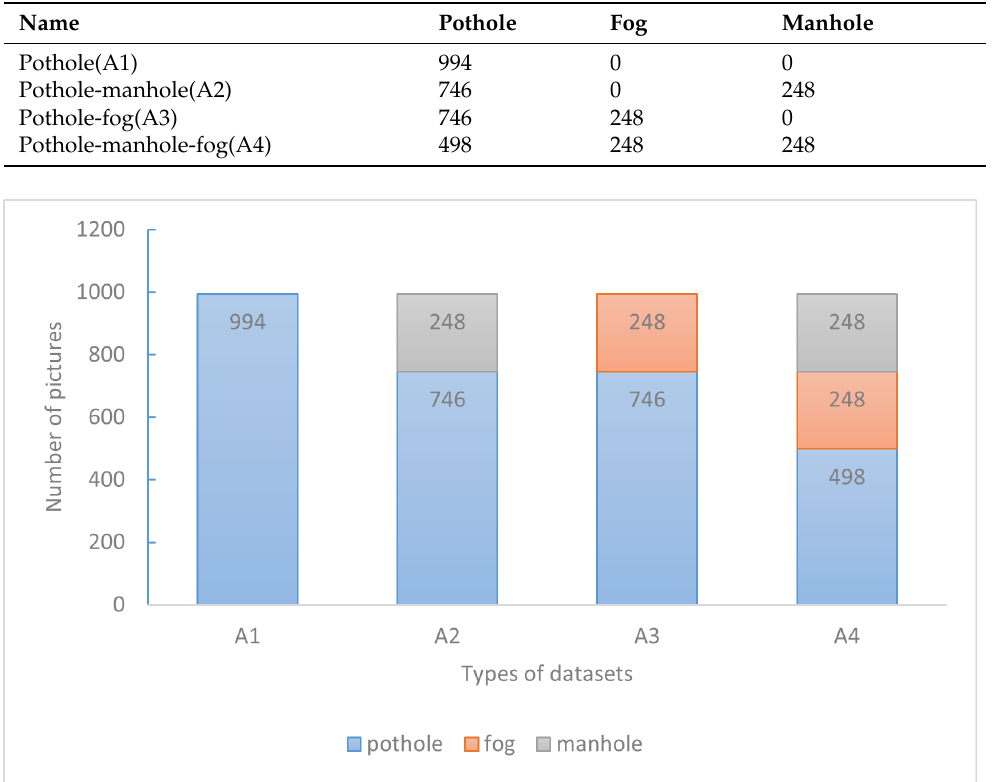
Table 1. Number of photos of each type in A1, A2, A3, A4 of the self-made dataset.